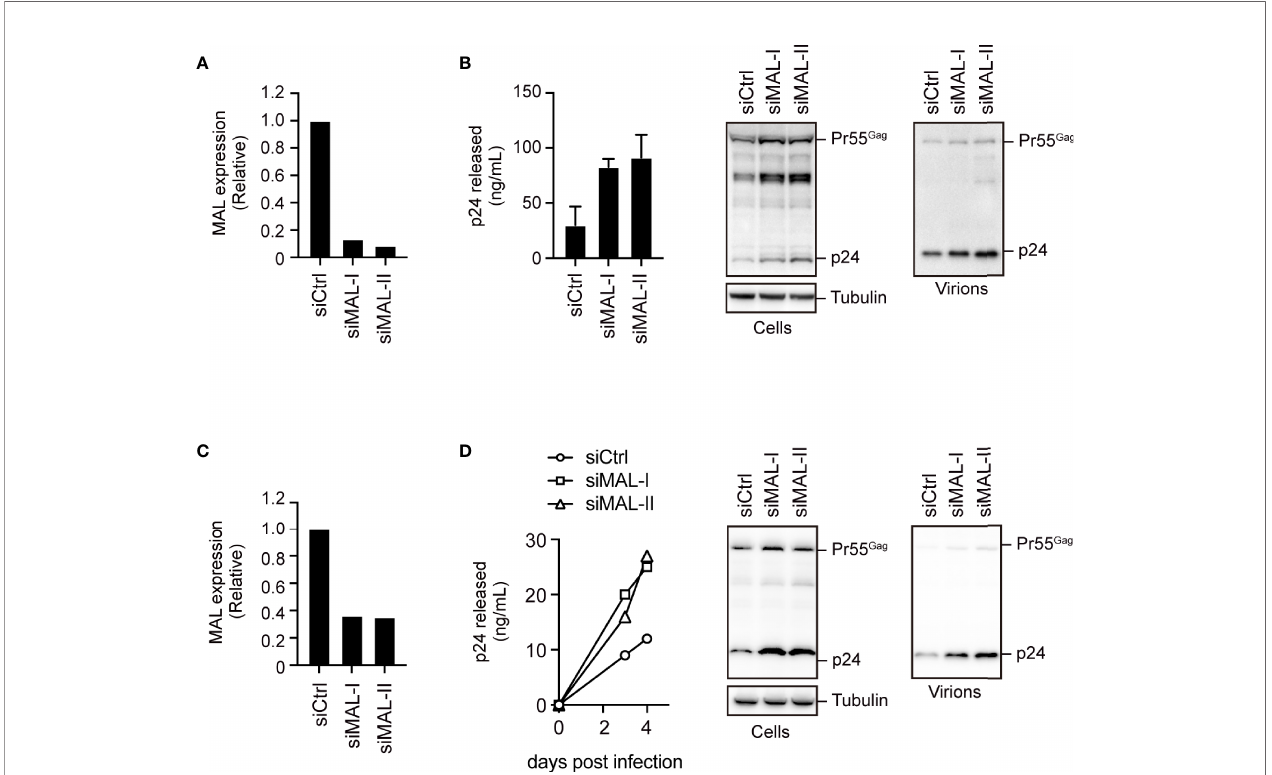
FIGURE 4 | Endogenous MAL expression inhibits HIV-1 production. (A, B) PC3 cells transduced with control-(Ctrl) or MAL-targeting siRNAs (siMAL-I and siMAL-II) were transfected with pNL4-3. MAL knockdown was con fi rmed by RT-PCR (A) . Following transfection, cell lysates (Cells) and the culture supernatants (Virions) were subjected to immunoblotting and p24 levels were measured by ELISA (B) . (C, D) CEM T cells transduced with indicated siRNAs were infected with HIV-1. MAL knockdown was con fi rmed by RT-PCR (C) . The supernatants were harvested at 3 and 4 days post-infection and p24 levels were measured by ELISA. At 4 days post-infection, cell lysates and the culture supernatants (virions) were subjected to immunoblotting (D)